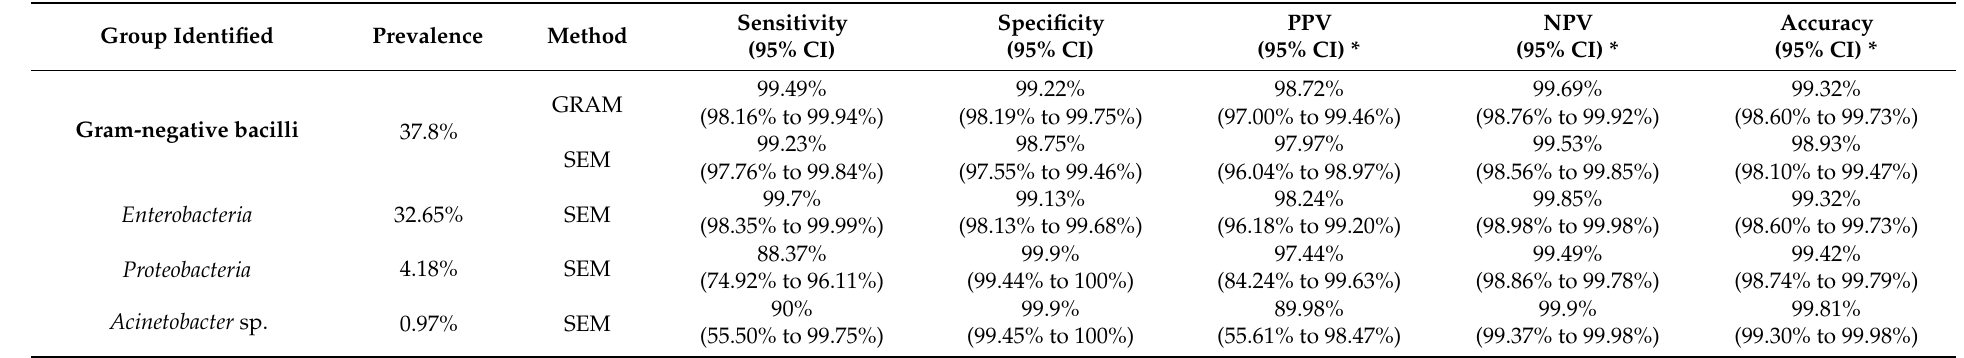
Table 2. Performance characteristics for bacilli-shaped bacterial identification using SEM vs. Gram staining with culture-based MALDI-TOF/MS identification as a reference. Group